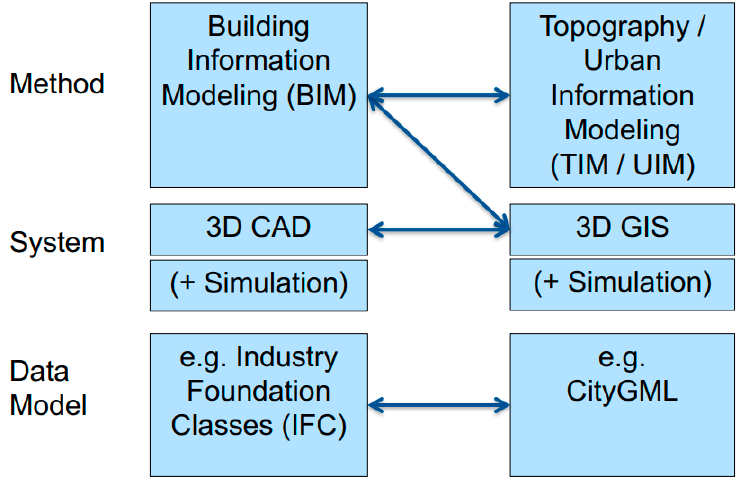
Figure 1. Building information model (BIM)–computer-aided design (CAD) level of integration, the link from BIM to 3D geographic information systems (GIS) referring to implementation of the BIM methods using GIS technology/concepts.